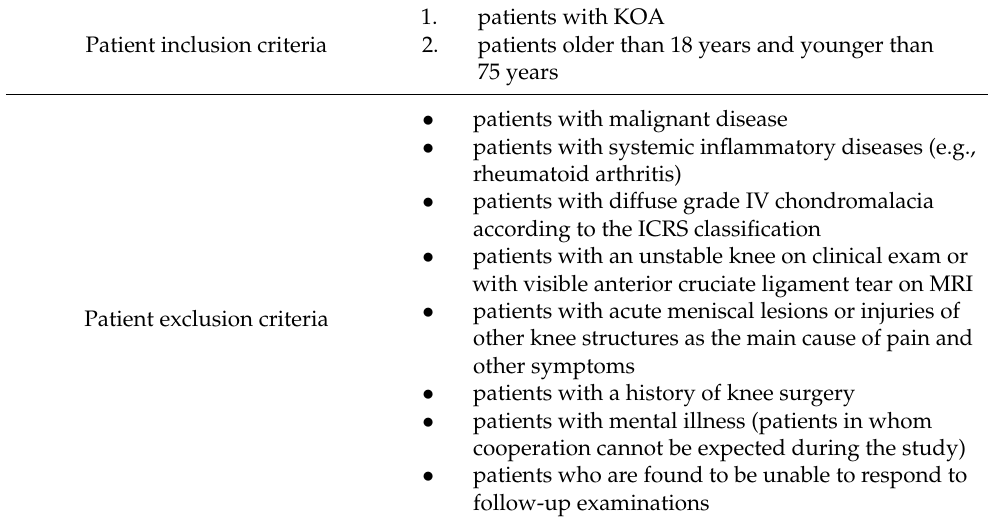
Table 1. Patient inclusion and exclusion